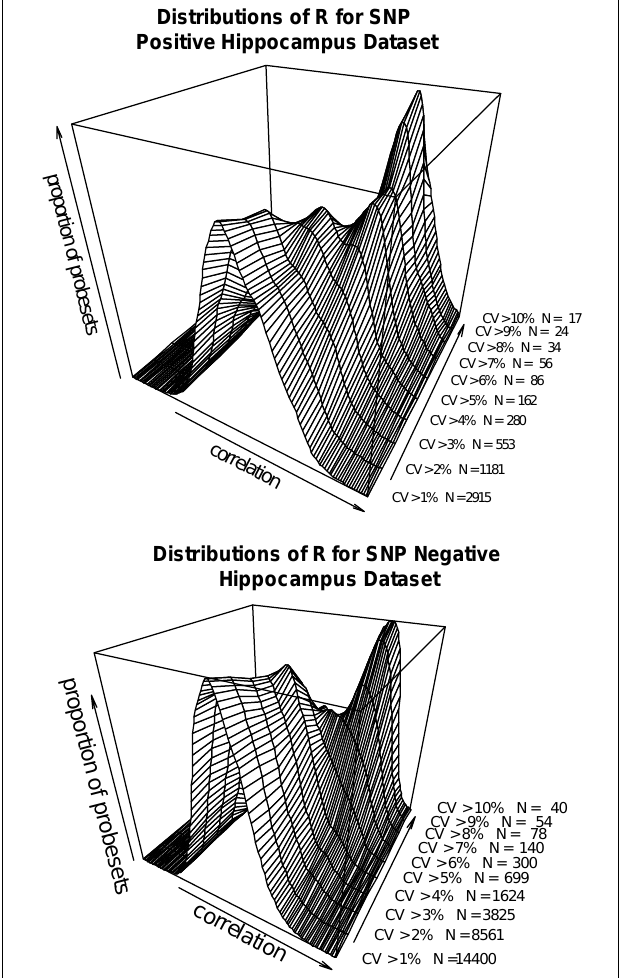
FIGURE 4 | (A,B) Pearson’s product-moment correlation plotted against the density of CV values for the range of CV > 0.1, CV > 0.2 … CV > 0.10 in the hippocampus SNP positive (A) and SNP negative (B)